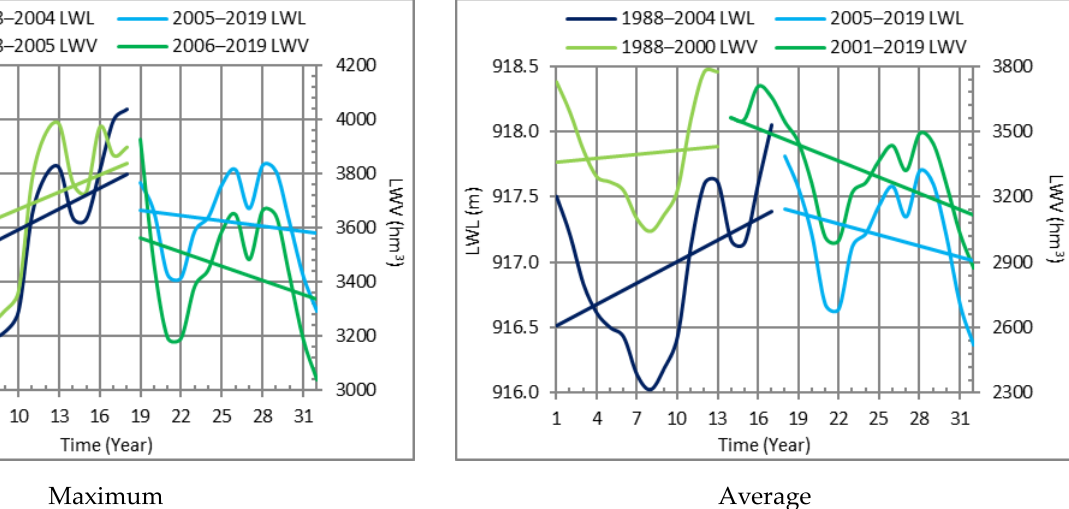
10 of 24 Minimum Figure 3. Measured annual LWL and LWV series of Lake Eğirdir. As shown in Figure 3, it was determined that the maximum, average, and minimum values of the lake water level values increased and decreased from time to time, and there was a general decrease in the lake water volume values. In addition, we can say that both the lake water level and the lake water volume have decreased in recent years. However, temporal changes in the hydrometeorological variables affect series data directly and in- directly, causing differences in the random variability of the series [69,70]. Therefore, there may be very important dependencies between the serial data. According to Fethi et al.